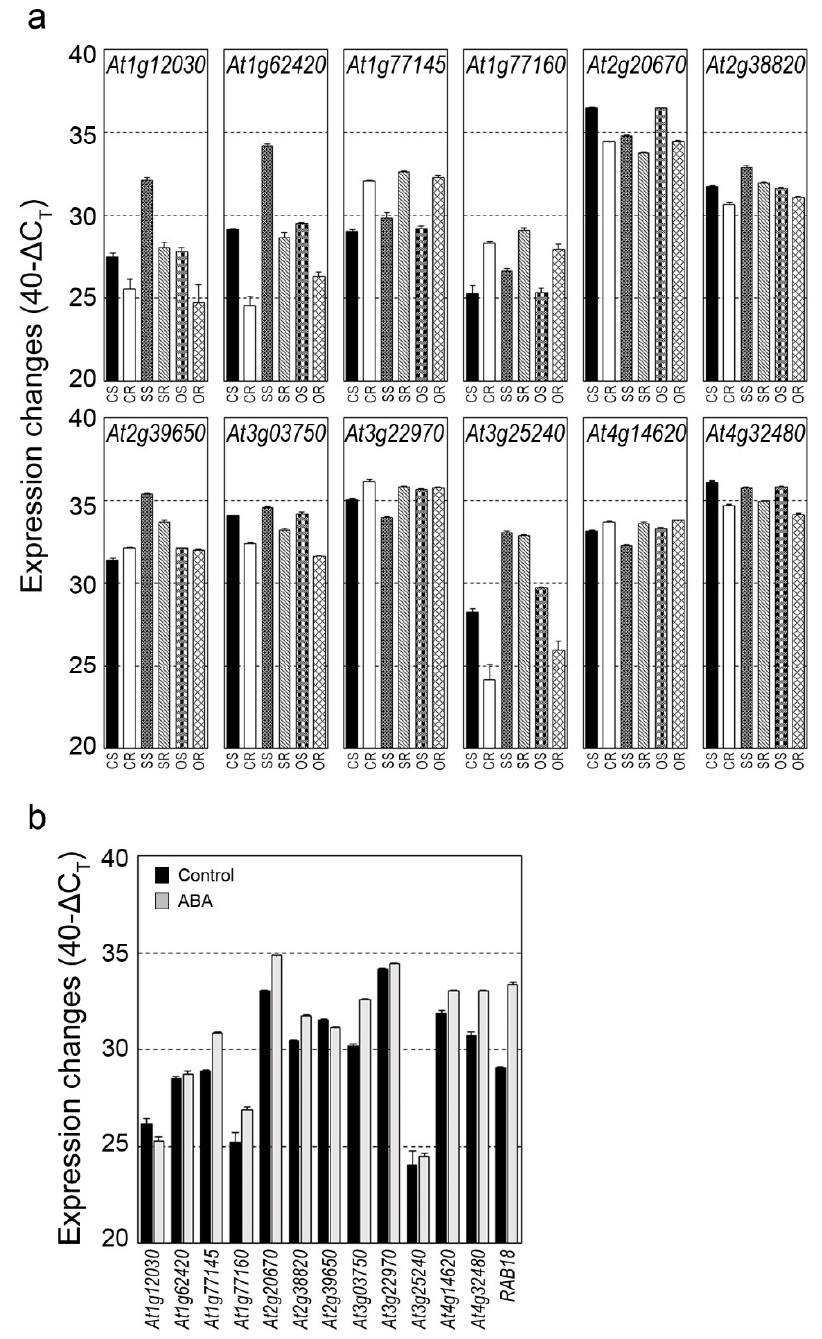
Figure 6. Expression profile of Arabidopsis DUF506 genes in response to salt or osmotic stress ( a ) and Abscisic acid (ABA) treatment ( b ). CS, control shoot tissue; CR, control root tissue; SS, salt stress shoot tissue; SR, salt stress root tissue; OS, osmotic stress (mannitol) shoot tissue; OR, osmotic stress root tissue. At5g66400/RAB18 , which is strongly induced by ABA, was used as positive external control ( b ).